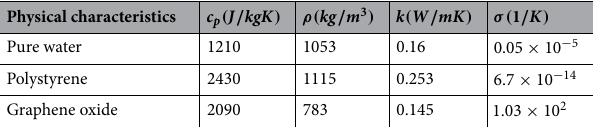
Table 1. Thermo-physical features of nanoparticles with base fluid.